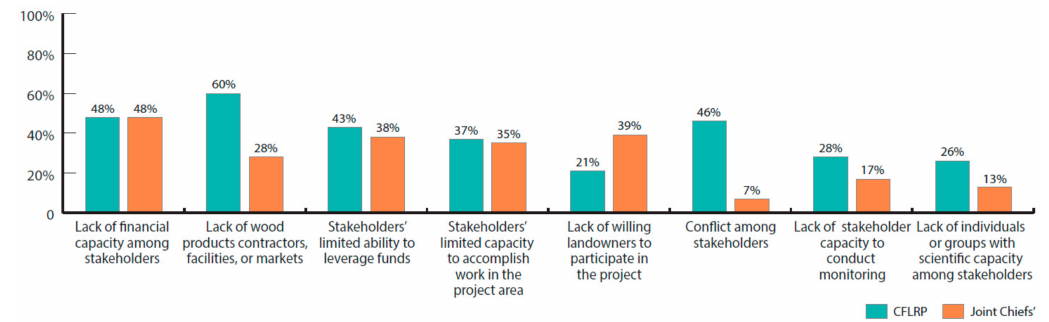
Figure 7. Percent of respondents who said that external factors were a major challenge or somewhat of a major challenge that hindered project success. Note: The items in the figures were the ones selected by the most participants and do not include all items included in the respective sections of the